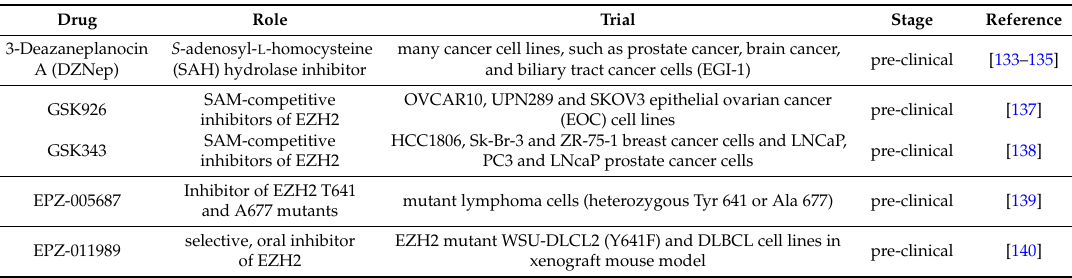
Table 6. Pre-and clinical trials of drugs related to